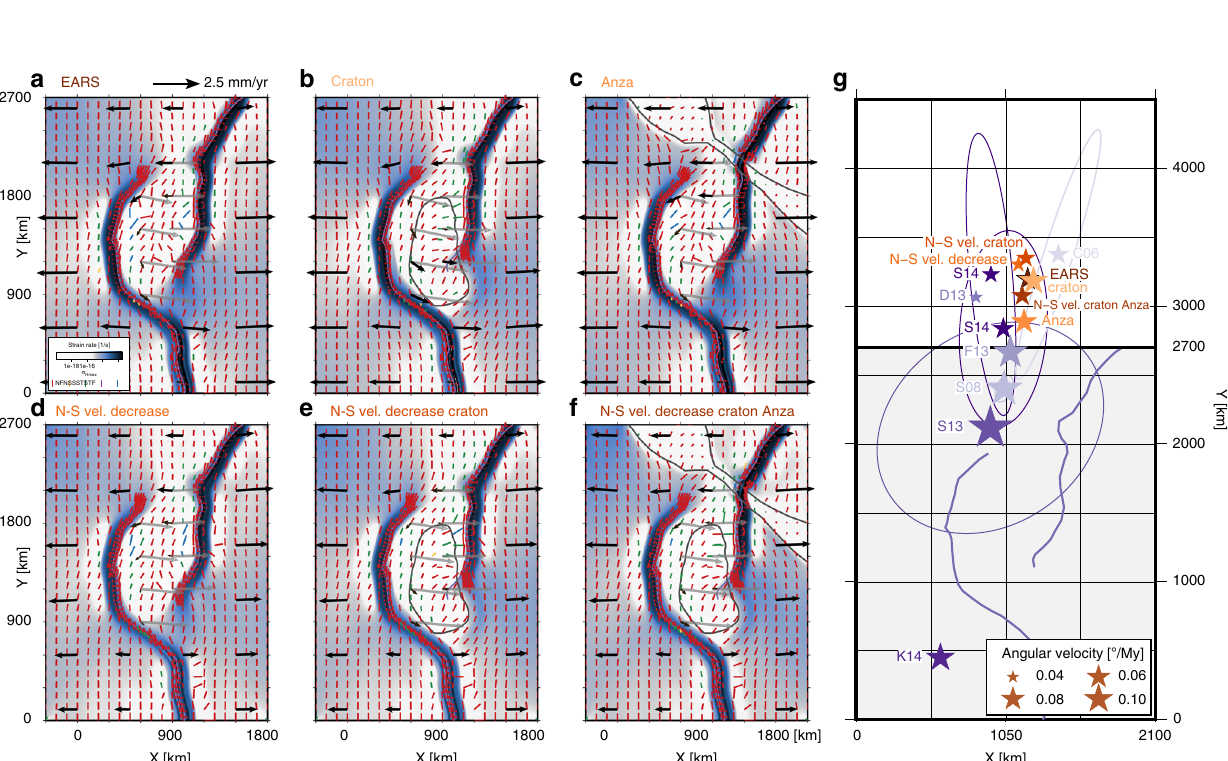
RMSD root-mean-square residual distance. Italic values indicate the parameters varied with respect to the fi rst model EARS (*). v e = 0.3983myr − 1 , Ω = 9.4295×10 − 5 myr − 1 km − 1 , y c = 1350km.